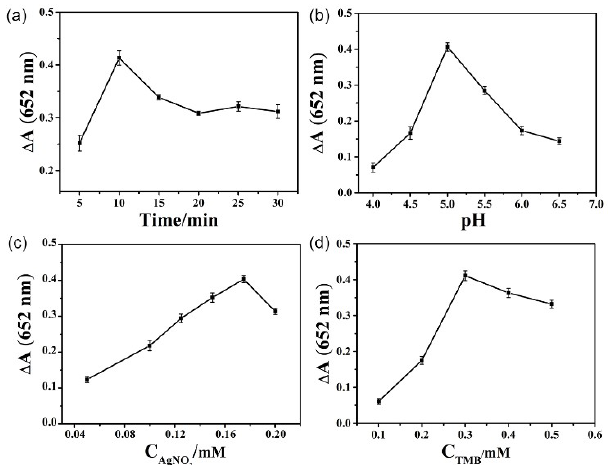
Figure 2. ( a ) Effect of incubation time on the ∆ A (0.2 M NaAc buffer, pH 5.0, 0.3 mM TMB, 0.175 mM AgNO 3 and 500 nM oleic acid). ( b ) Effect of pH on the ∆ A (0.2 M NaAc buffer, 0.3 mM TMB, 0.175 mM AgNO 3 , 500 nM oleic acid and 10 min incubation). ( c ) Effect of AgNO 3 concentration on the ∆ A (0.2 M NaAc buffer, pH 5.0, 0.3 mM TMB, 500 nM oleic acid and 10 min incubation). ( d ) Effect of TMB concentration on the ∆ A (0.2 M NaAc buffer, pH 5.0, 0.175 mM AgNO 3 , 500 nM oleic acid and 10 min incubation).